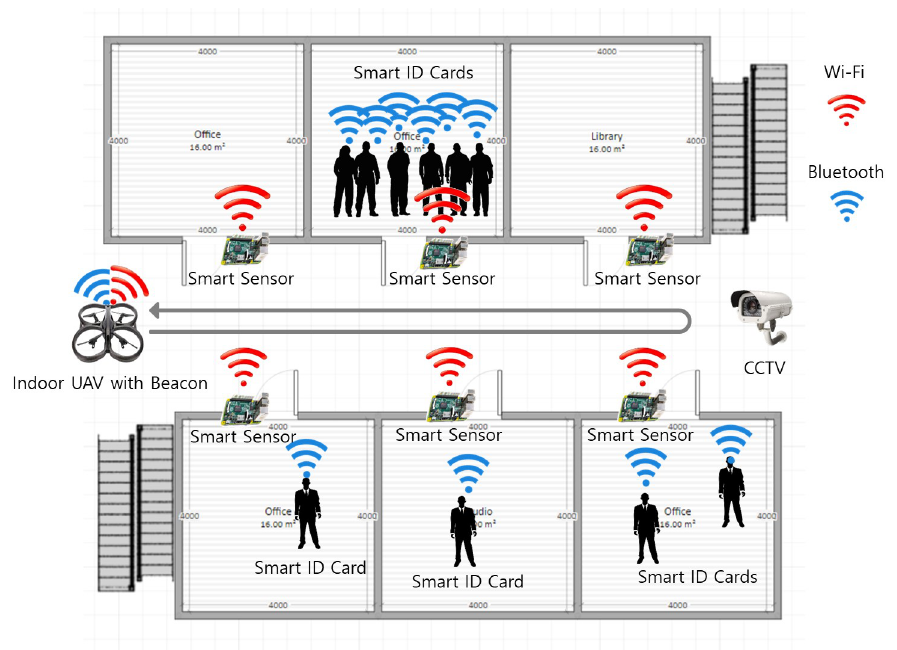
Figure 6. Emergency response